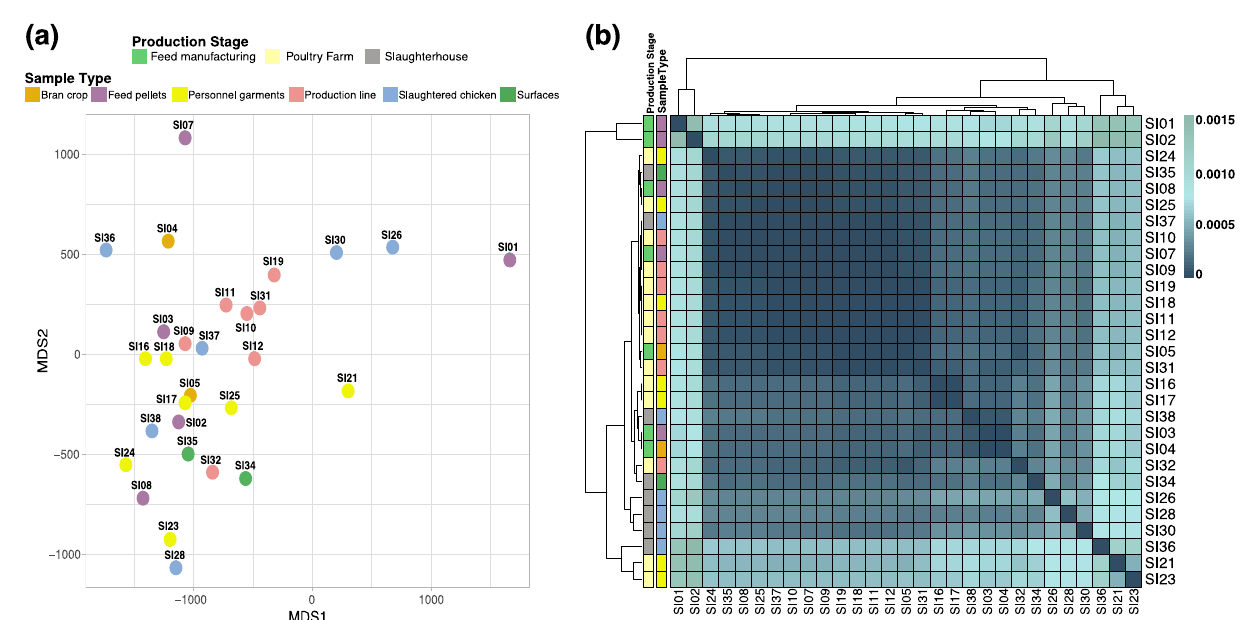
Figure 3. Genomic similarities among the S. Infantis strains. ( a ) Multidimensional scaling (MDS) plot based on average nucleotide identity (ANI) similarity index among the 29 S. Infantis genomes. ( b ) Heatmap representation of 29 genomes using Mash, heat scale is based on the pairwise Mash distances (identical genomes report a Mash distance of 0), the left and top dendrograms corresponds to complete-linkage hierarchical clustering. Colors of the dots and heatmap left columns represents the production stage and sample type.